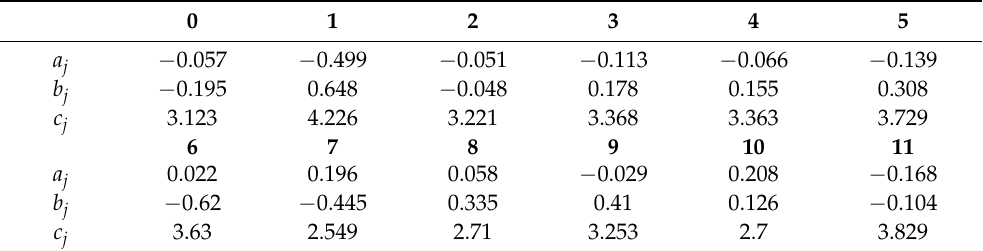
Table 4. Estimated Coefficients of the Fractal Curve from Polar